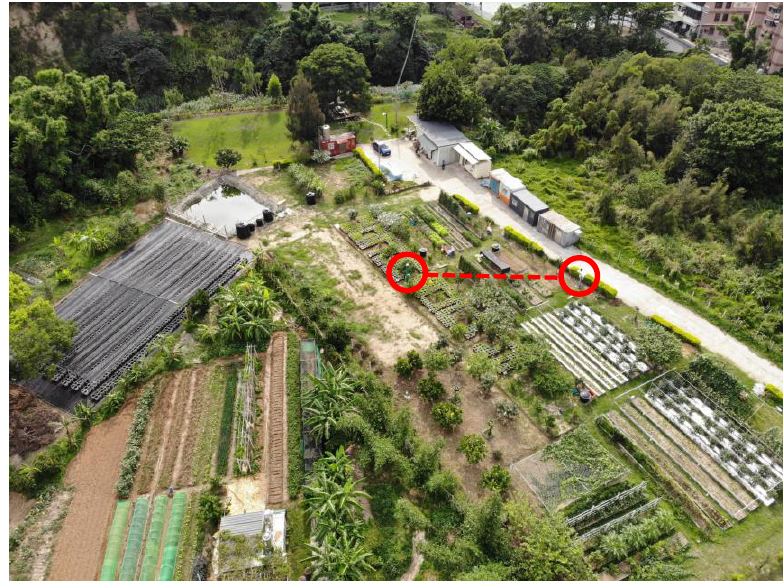
Figure 1. The Bao Farm (the weather stations are highlighted by the red circles).